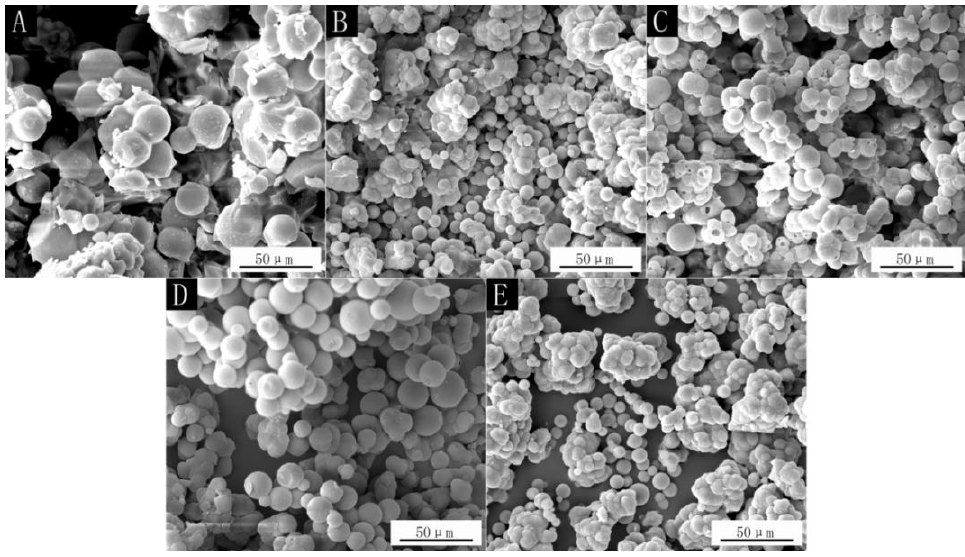
Figure 2. SEM of tung oil microcapsules emulsified by five emulsifiers ( A ) Span-80, ( B ) SDBS, ( C ) OP-10, ( D ) Tween-80, ( E ) SDS. ( C ) OP-10, ( D ) Tween-80, ( E )